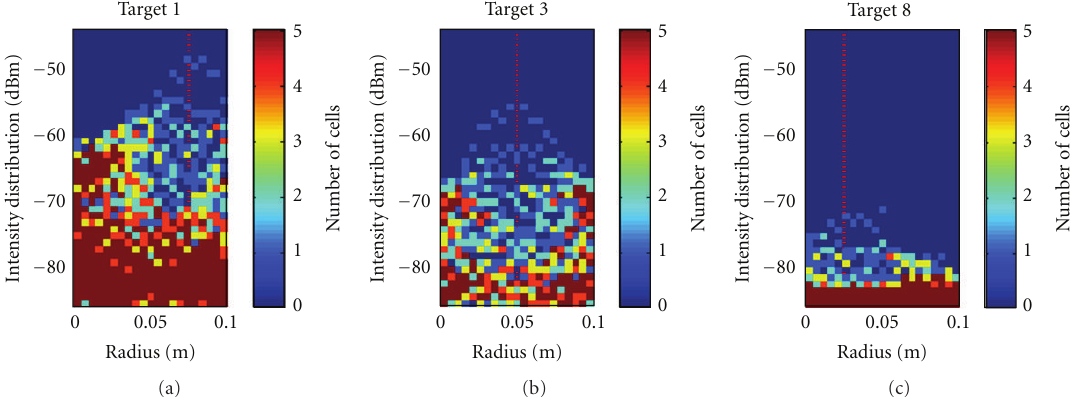
Figure 23: Intensity distribution per voxel within the proximity of simulated targets 1, 3 and